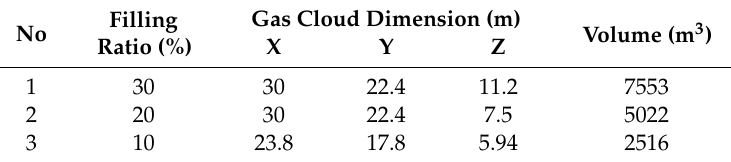
Table 3. Gas filling ratio and gas volume below the drill floor.